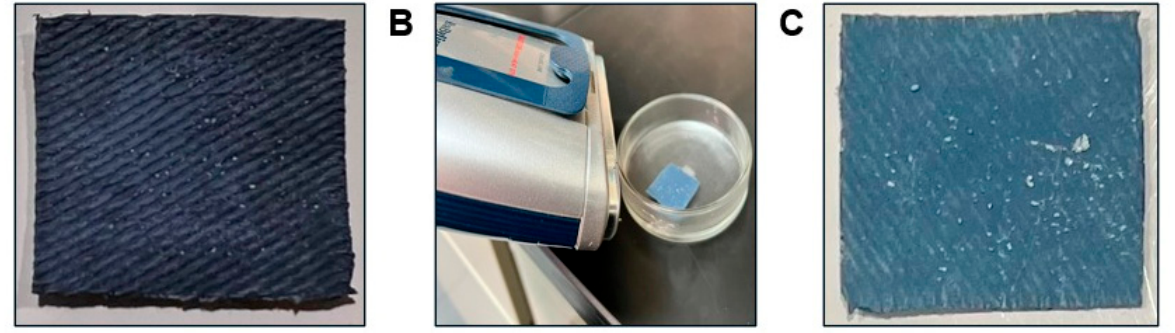
Figure 7. ( A ) Steam washing procedure. ( B ) Conductivity tests of the nanocomposite cotton fabrics after the steam washing procedure.